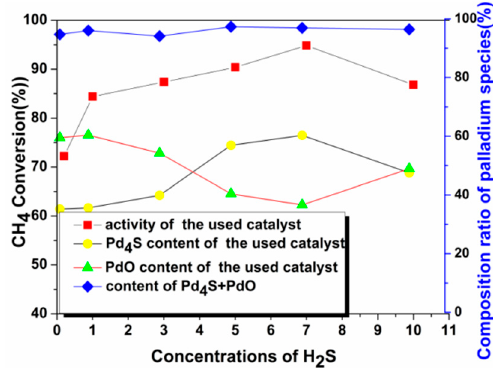
Figure 10. Relationship profile between composition ratio of Pd 4 S and PdO on used catalysts and second evaluation of methane conversion. The composition ratio of palladium species was calculated through Pd fitted peak area by XPS.